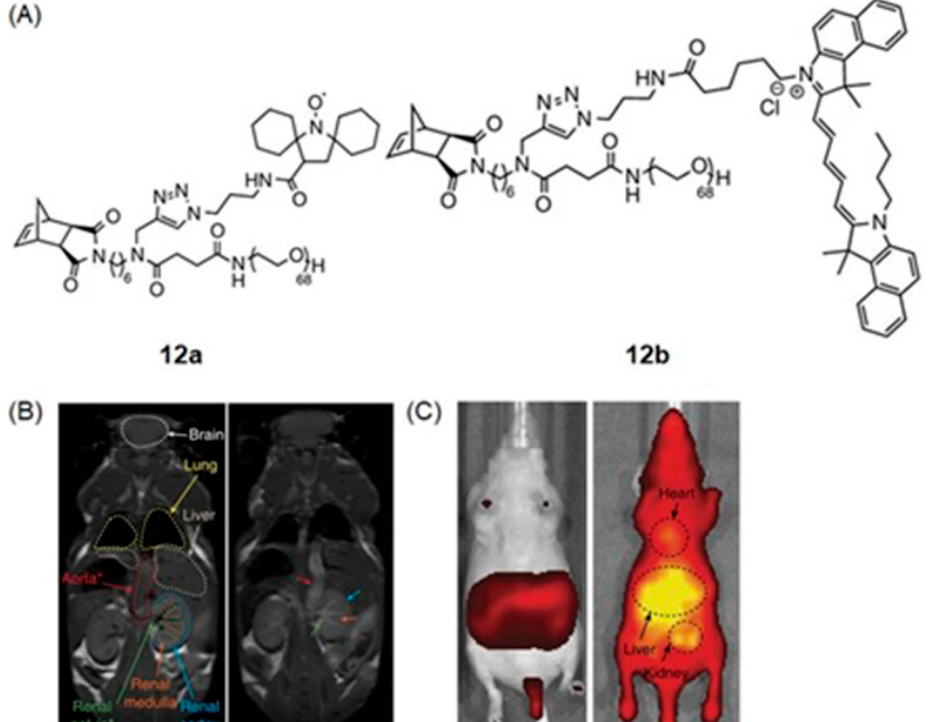
Figure 24. ( A ) Chemical structures of nitroxide-radical-containing organic molecule ( 12a ) and cyanin5.5 near-IR fluorophore ( 12b ) used to synthesize the polymer. ( B ) (left) T 1 -weighted MRI image of whole mouse before nanoparticle injection and (right) T 1 -weighted MRI image of the same mouse 30 min after nanoparticle injection. Some organs and tissues outlined for reference. The red asterisk indicates the structure labeled as aorta could also include inferior vena cava. The green asterisk indicates the structure labeled as renal pelvis could also include renal artery and renal vein. ( C ) Near-IR fluorescence imaging studies. (left) fluorescence image of whole mouse before nanoparticle injection. (right) fluorescence image of the same mouse in 30 min after injection. Maximum fluorescence is observed in the liver and kidneys, implying that the nitroxide radical-containing nanoparticles accumulate in the liver mostly in the reduced state. Adapted by permission from Springer